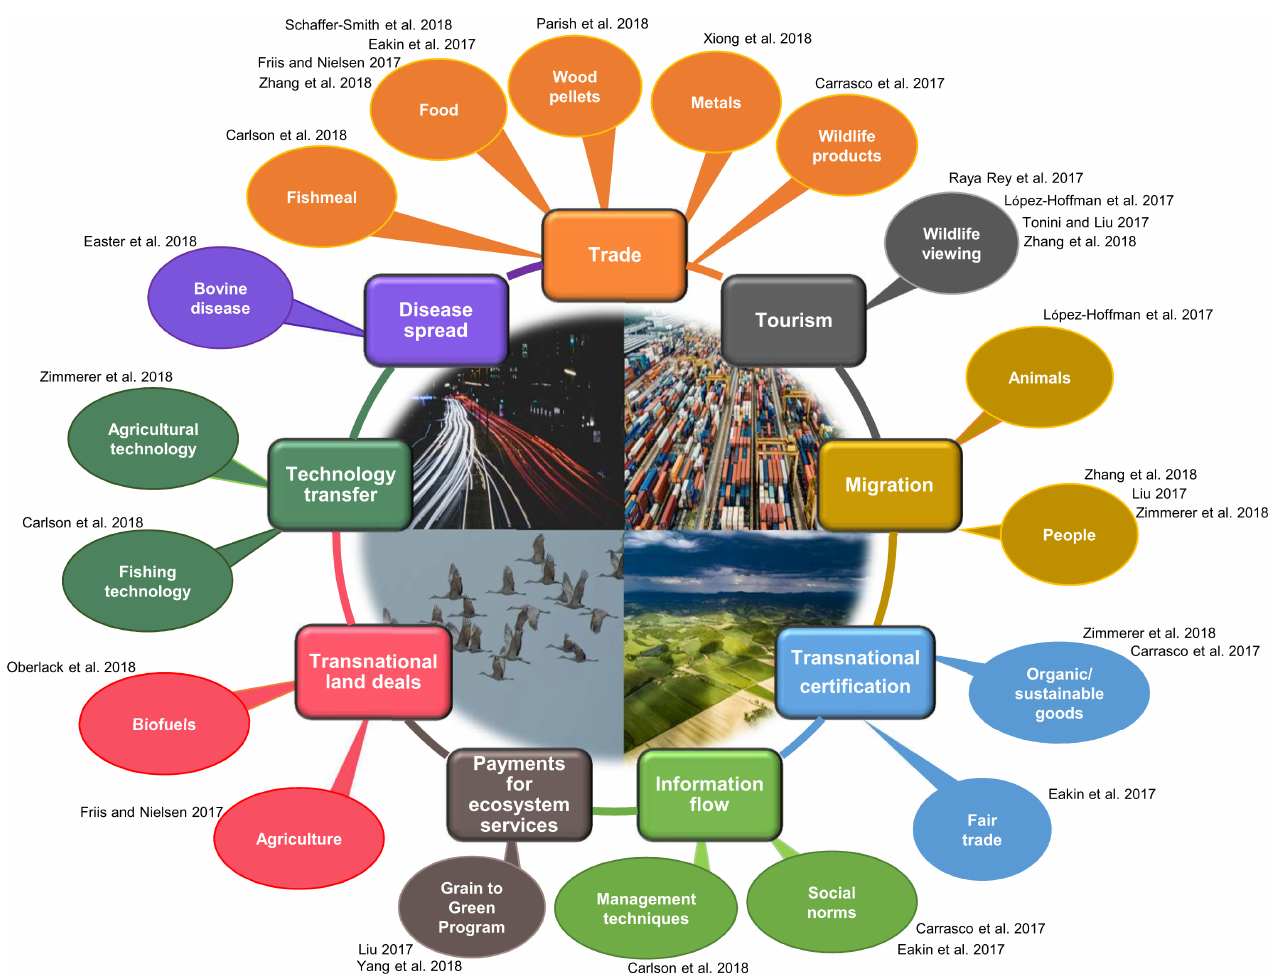
Fig. 1 . Schematic illustrating the major telecouplings (on the circle) and associated examples (bubbles) explored in the special